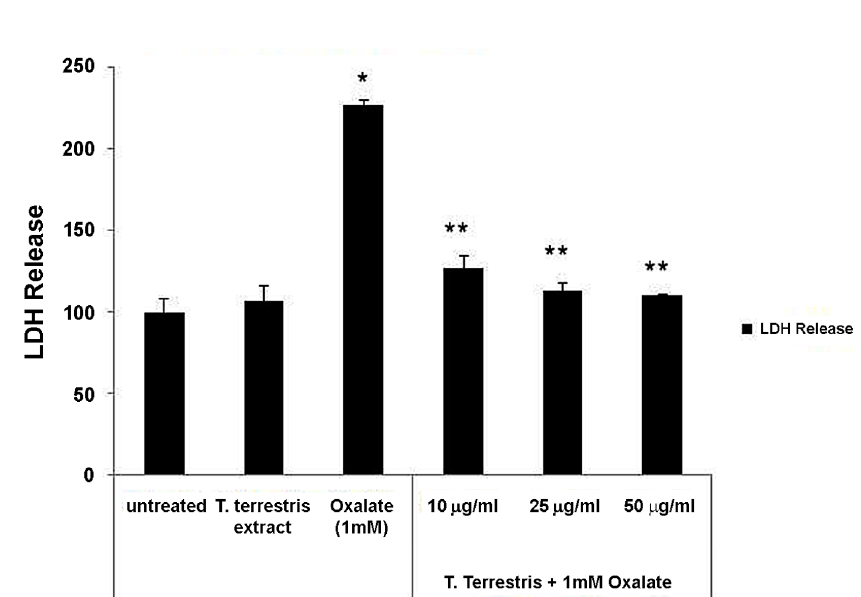
Figure 4 – Effect of Tribulus terrestris on the % LDH release. Data are mean ± SEM of three independent observations. * p < 0.05 versus untreated control, ** p < 0.05 versus oxalate